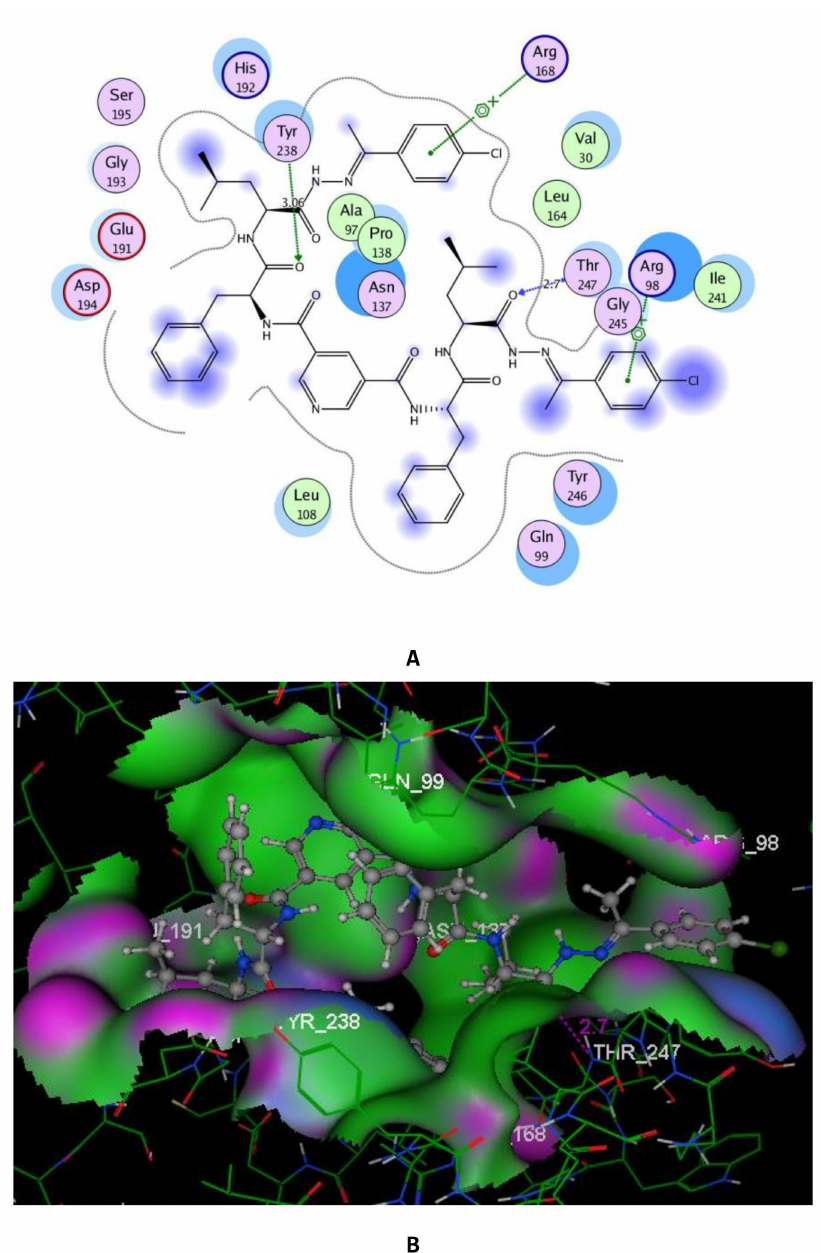
Figure 8. Two-dimensional ( A ) and 3D ( B ) patternsillustrating the proposed binding mode of the compound 5c in the LDHA binding pocket (PDB code: 4ZVV). Hydrogen bonding interactions with the protein are shown as dashed lines. Green color reflects a hydrophobic area, pink color reflects a high polar area, and blue color reflects a mild polar